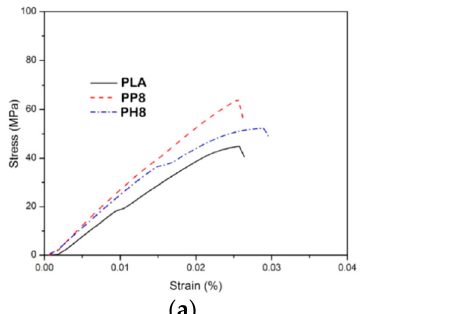
( a ) ( b ) Figure 9. ( a , b ) Stress-strain curves of neat PLA and PLA containing hydroxyapatite (HA) nanoparticles modified with phosphorus-based organic additives [43], Reproduced with permission from Hajibeygi M, Polym. Adv. Technol.; published by Wiley, 2019. Table 5. Values of the tensile strength (TS), Young’s modulus (YM), and elongation at break (EB) [43], Reproduced with permission from Hajibeygi M, Polym. Adv. Technol.; published by Wiley, 2019 . Tensile Strength, MPa Young Modulus, GPa Elongation at Break, %